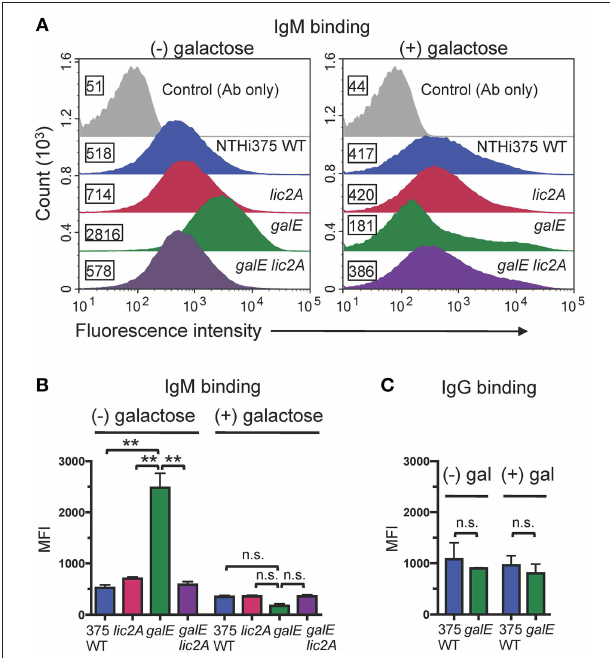
FIGURE 8 | Increased binding of IgM but not IgG to the NTHi 375 galE mutant. (A) IgM binding to NTHi 375 wild-type (WT) and isogenic mutants grown in the absence or presence of 0.5% galactose in MIc SA then incubated with 20% NHS 1 i followed by detection with anti-human IgM conjugated to FITC via flow cytometry. X-axis, fluorescence; Y-axis, counts. Numbers alongside the histograms indicate the MFI of the bacterial population. Control Ab only fluorescence values are similar for all strains and only one representative is shown (NTHi 375 WT). One representative experiment of two reproducible repeats is shown. (B) IgM and (C) IgG binding for the mean of replicate samples of which one is shown in (A) for IgM. Statistical significance was evaluated by one-way ANOVA with Bonferroni’s multiple comparison test (** p < 0.01; n.s., not statistically